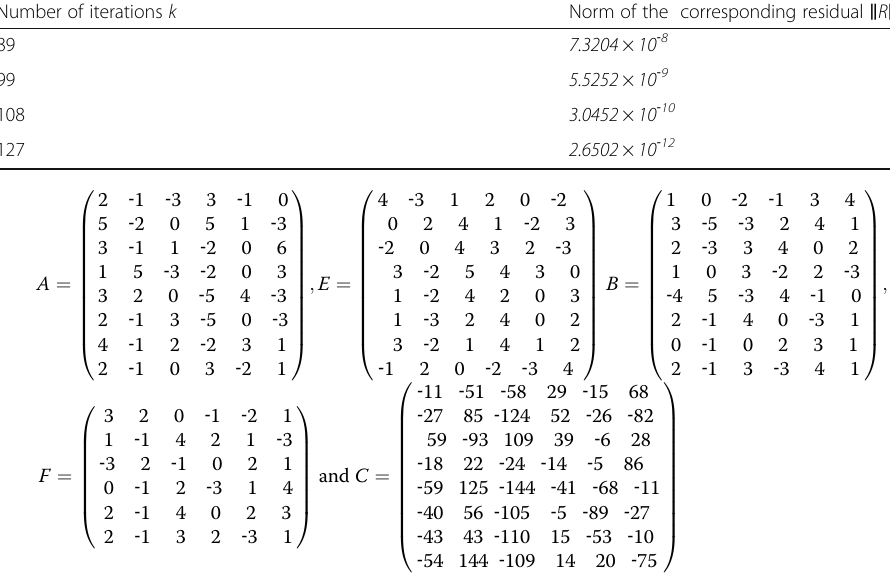
Table 3 The number of iterations and norm of the corresponding residual for the reflexive solution of the generalized Sylvester matrix equation Example 4.3